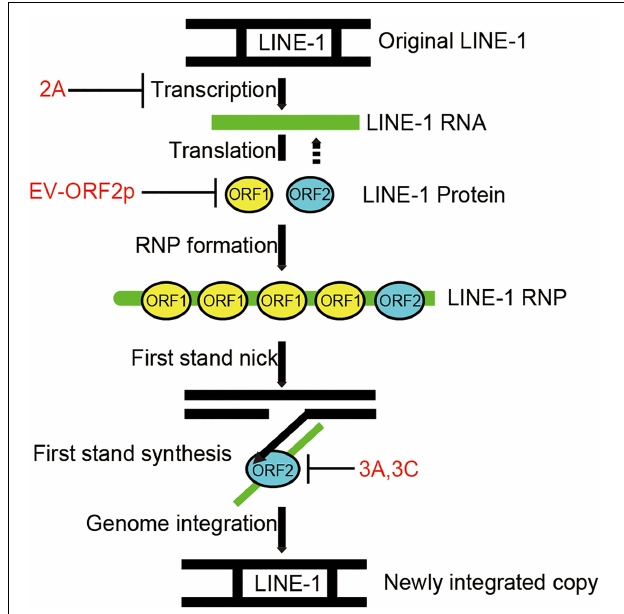
FIGURE 7 | Diagram indicating that EV non-structural proteins 2A, 3A, 3C, and EV-ORF2p inhibit LINE-1 retrotransposition. LINE-1 is transcribed into LINE-1 RNA, and then the LINE-encoded proteins are translated. LINE-1 proteins interact with LINE-1 RNA to facilitate the assembly of LINE-1 ribonucleoproteins (RNPs). The LINE-1 ORF2p (endonuclease activity) nicks the bottom strand of the target site DNA. The LINE-1 ORF2p (reverse transcriptase activity) reverse transcribed the LINE-1 RNA using the 3’ hydroxyl group generated by LINE-1 ORF2p endonuclease activity as a primer. This process is a target-primed reverse transcription (TPRT). The DNA/RNA heteroduplex was converted to a DNA/DNA duplex and integrated into the target site. However, the underlying mechanisms remain